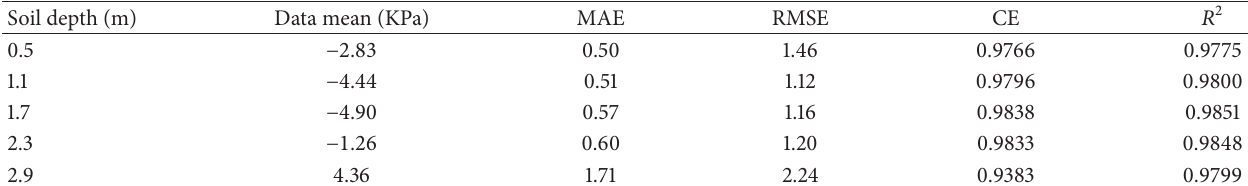
Table 3: Performance statistics of ANN at different soil depths during testing